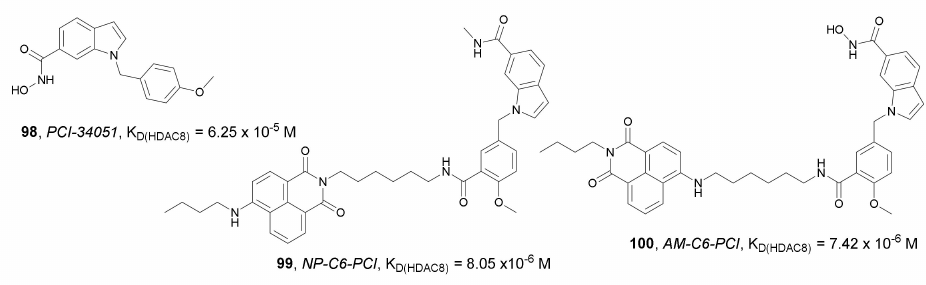
Figure 34. Chemical structures of PCI-34051 98 , 10NP-C6-PCI 99 , and 13AM-C6-PCI 100